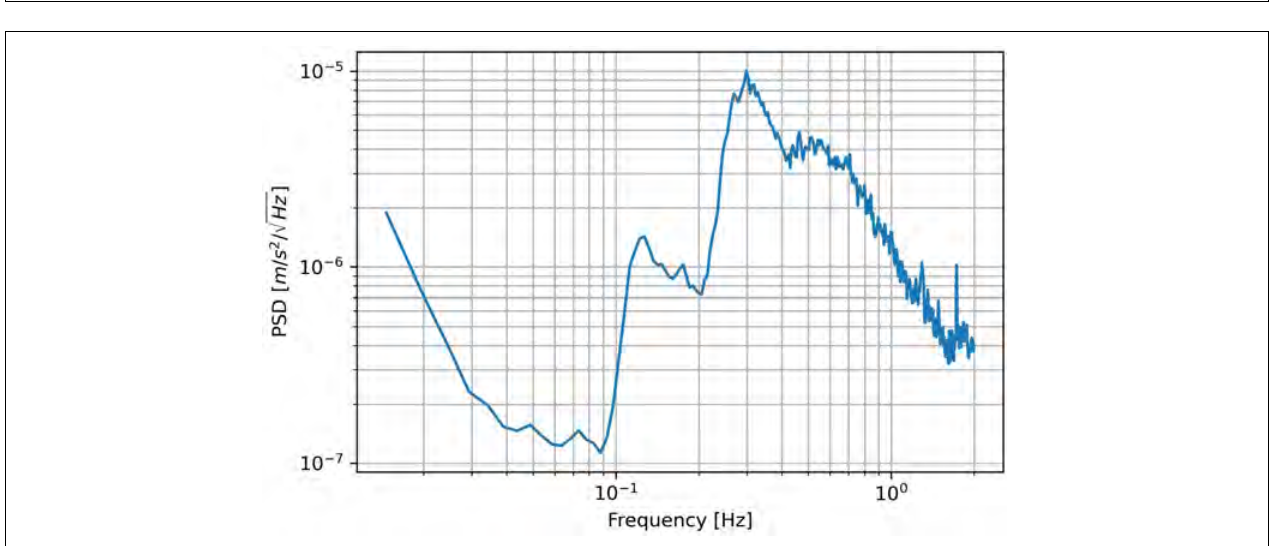
FIGURE 5 | The time plots (A–C) show five buoy records from 22:20 to 23:00 on the February 5, 2014. In (D) is shown the spectrogram of the micro-seismic signal, i.e., the five columns represent the five PSDs corresponding to the timings indicated by the labels on the x axis.